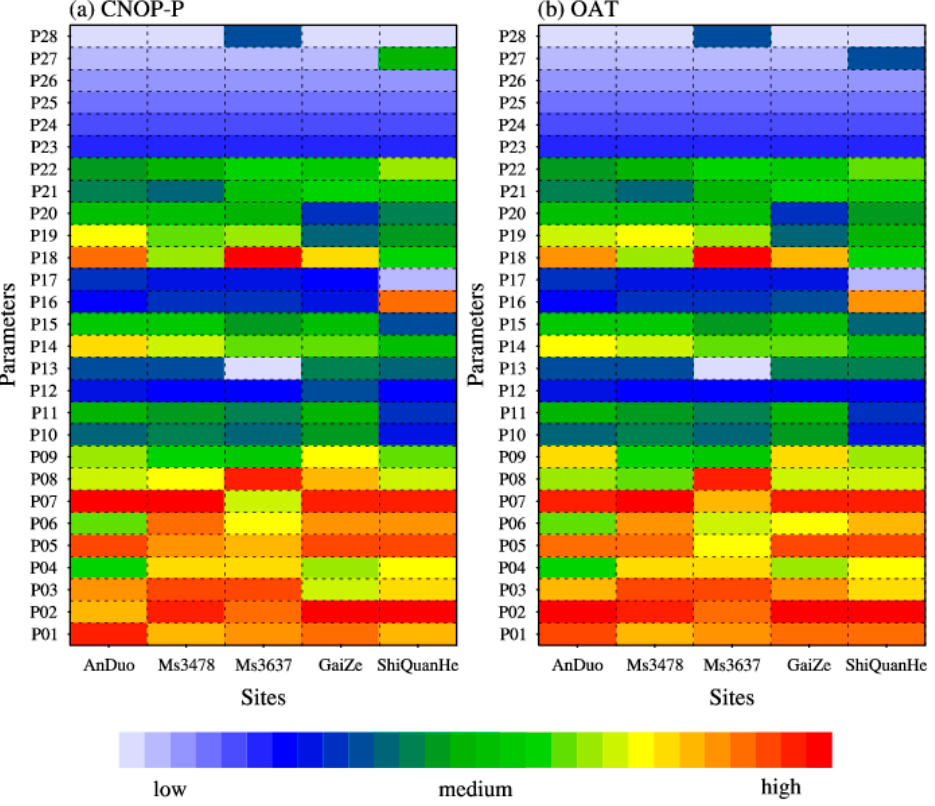
Figure 10. The ranks of the sensitivities of all 28 parameters based on single parameter sensitivity analyses using the CNOP-P approach ( a ) and the OAT method ( b ) for ST.